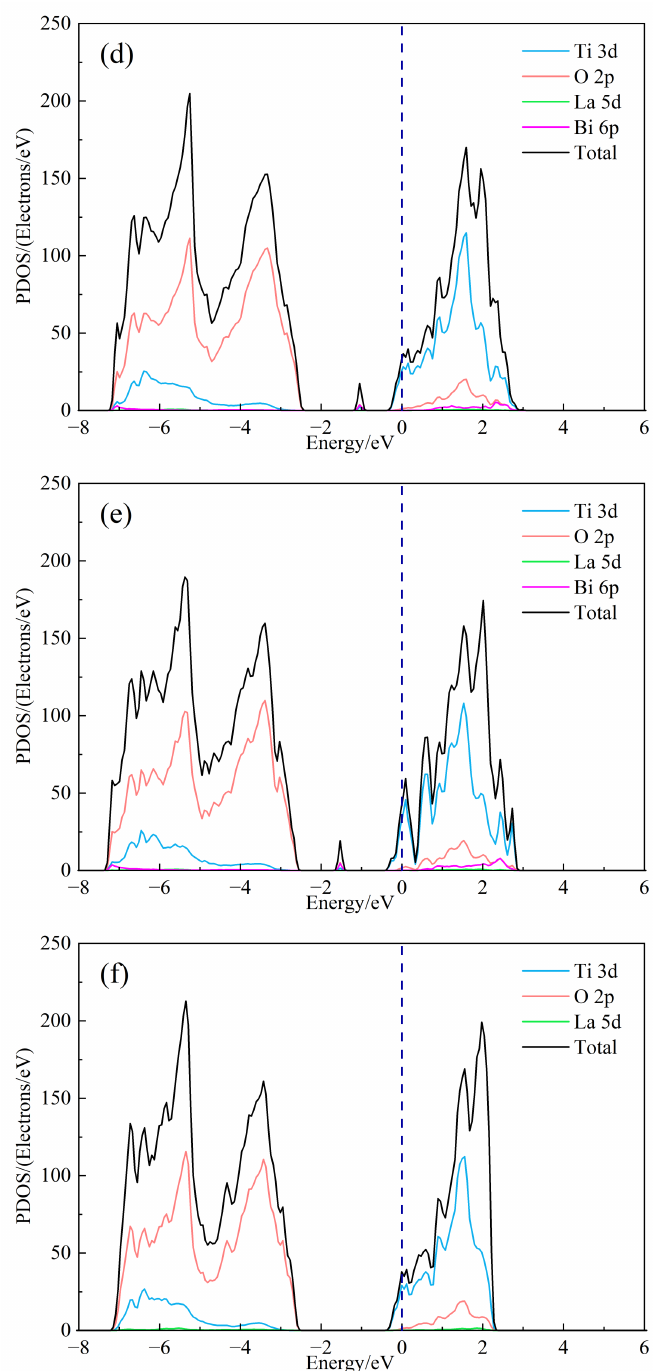
Figure 3. The DOS of (Sr 0.889-x La 0.111 Bi x )TiO 2.963. ( a ) Sr 0.889 La 0.111 TiO 2.963; ( b ) Sr 0.852 La 0.111 Bi 0.037 TiO